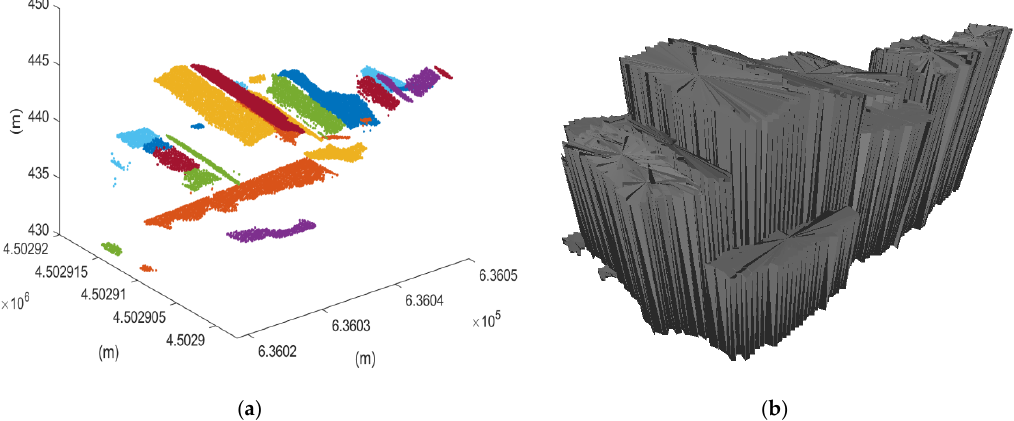
Figure 3. Region growing approach. ( a ) Segmentation of roof light detection and ranging (LIDAR) points displayed in Figure 1b. ( b ) 3D building reconstruction.